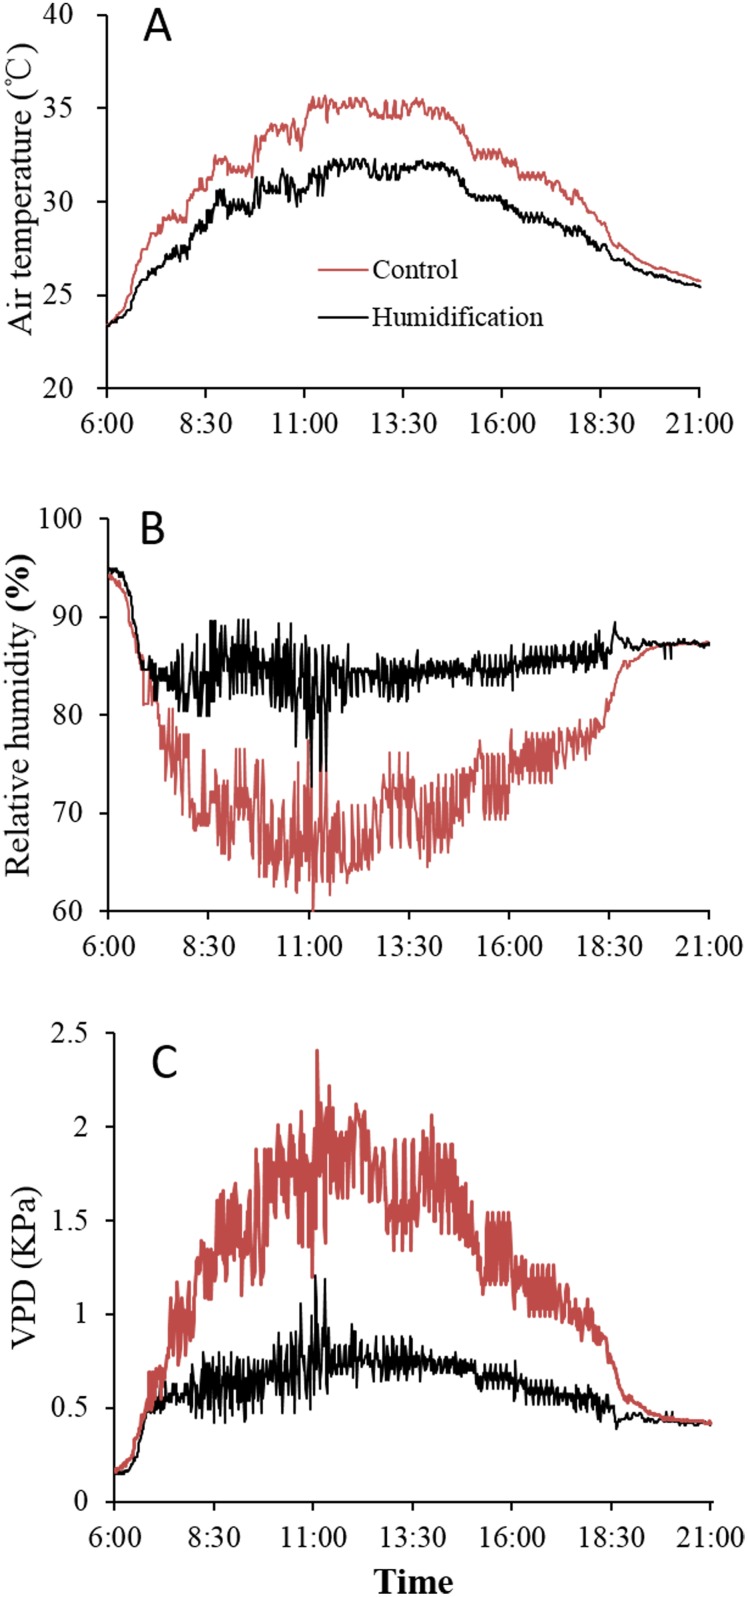
Comparison of typical diurnal variation of greenhouse environment.Air temperature, relatively humidity, VPD between control and humidification treatment were measured at DAT 34 (19 Aug).